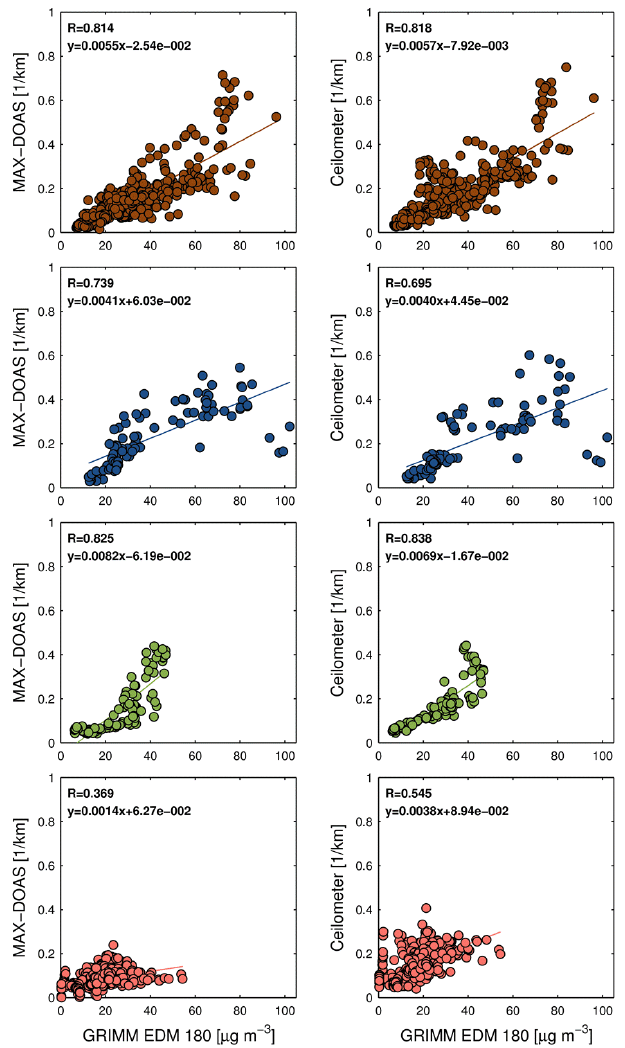
Figure 11. Same as Fig. 10 but for the visible channel.